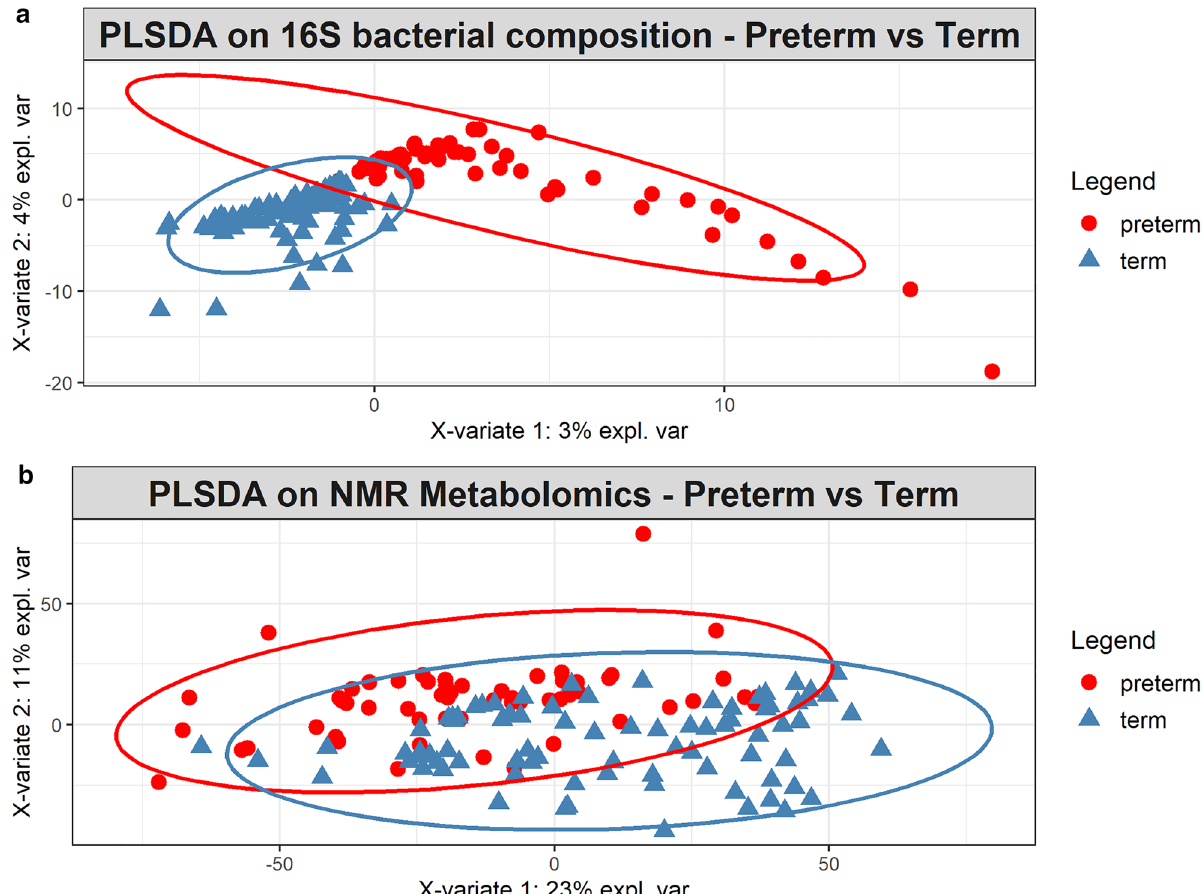
Figure 1. Faecal bacterial and metabolite composition of preterm and term control. PLS-DA models depicting inter-subject distances based on the ( a ) 16S bacterial composition (fivefold cross-validation, 2 components, overall error rate = 0.30) and ( b ) NMR metabolomics (fivefold cross-validation, 2 components, overall error rate = 0.29). Prevalence uncovers distinct clusters among the subject group. Eclipses for each group are calculated based on a 95% confidence level. PLS-DA plots were generated using R statistical software (version 3.5.0, https ://cran.r-proje